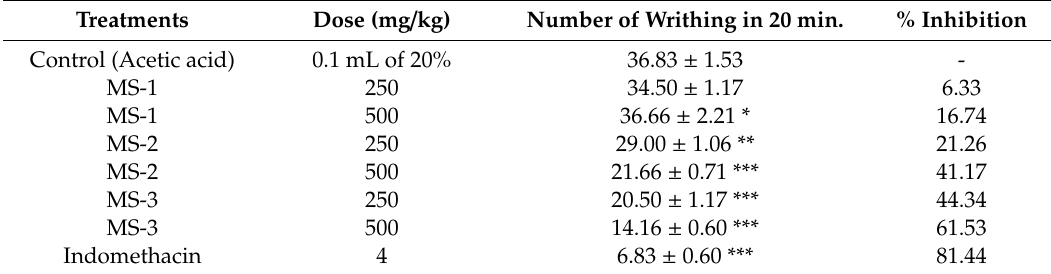
Table 3. Analgesic e ff ects of M. sinaica fractions on acetic acid–induced writhing in mice. Treatments Dose (mg /